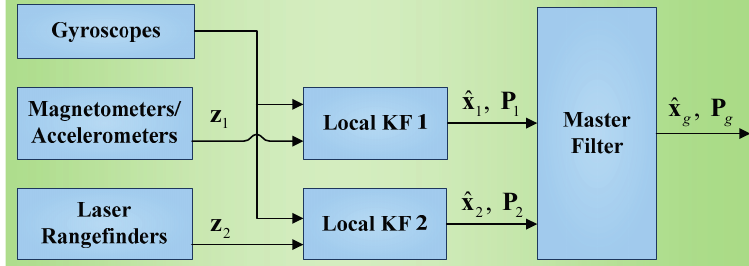
Figure 8. The FKF structure in the target positioning